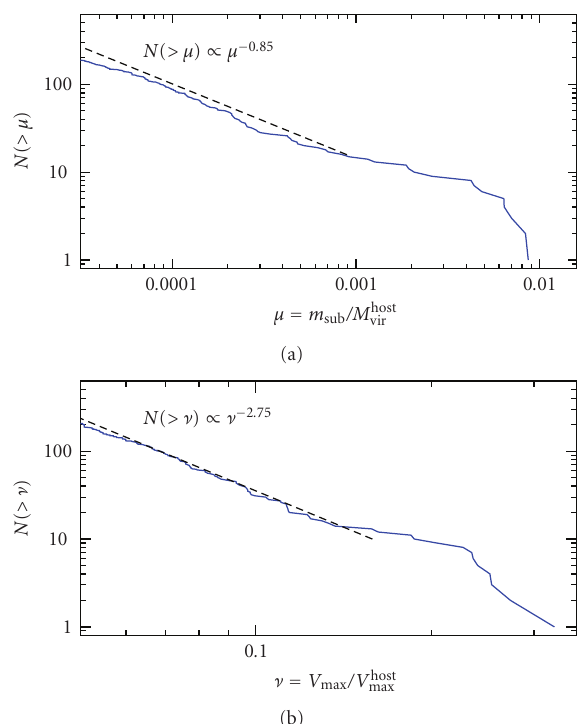
Figure 3: Cumulative circular velocity and mass function of subhalos within the virial radius R 337 = 328 kpc of a halo of virial mass M 337 = 2 × 10 12 M (cid:4) at z = 0. The dashed lines show power laws with the slopes indicated in the legend of each